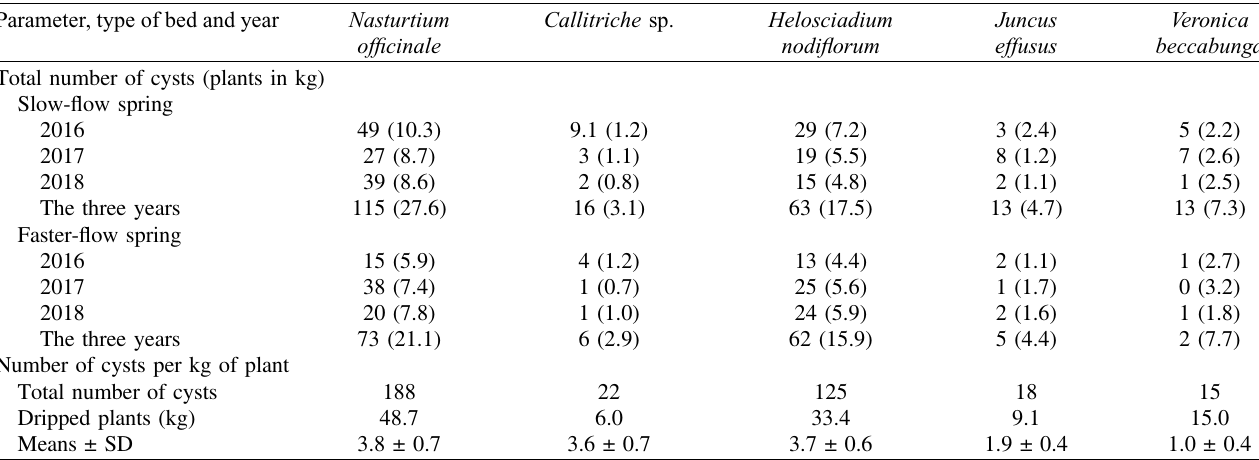
Table 2. Number of Fasciola hepatica metacercariae and weight of dripped plants in relation to the type of watercress bed and the year. The number of cysts per kg of plants was calculated on all metacercariae, without taking into account the type of bed.